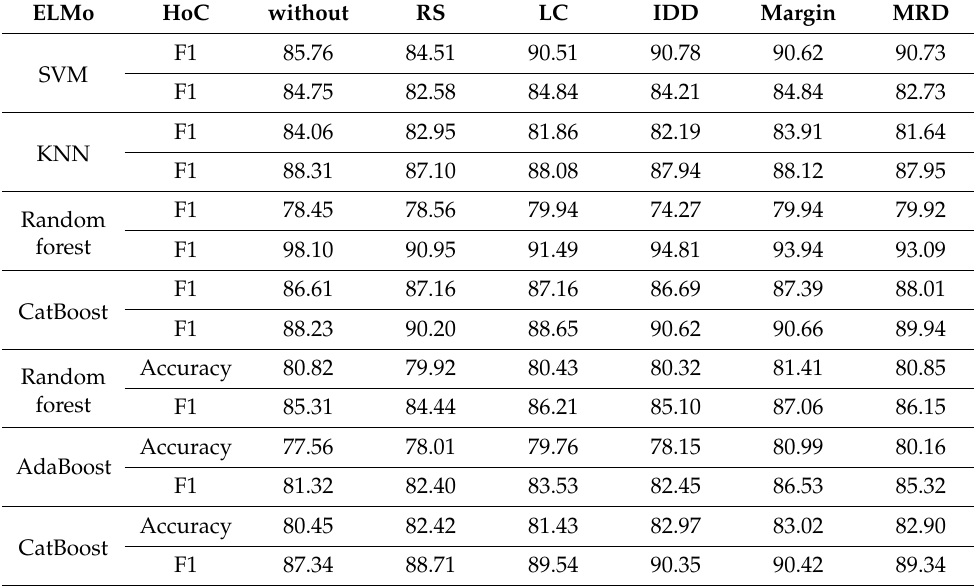
Table 12. Comparison of results with and without AL methods (ELMo) for HoC dataset.